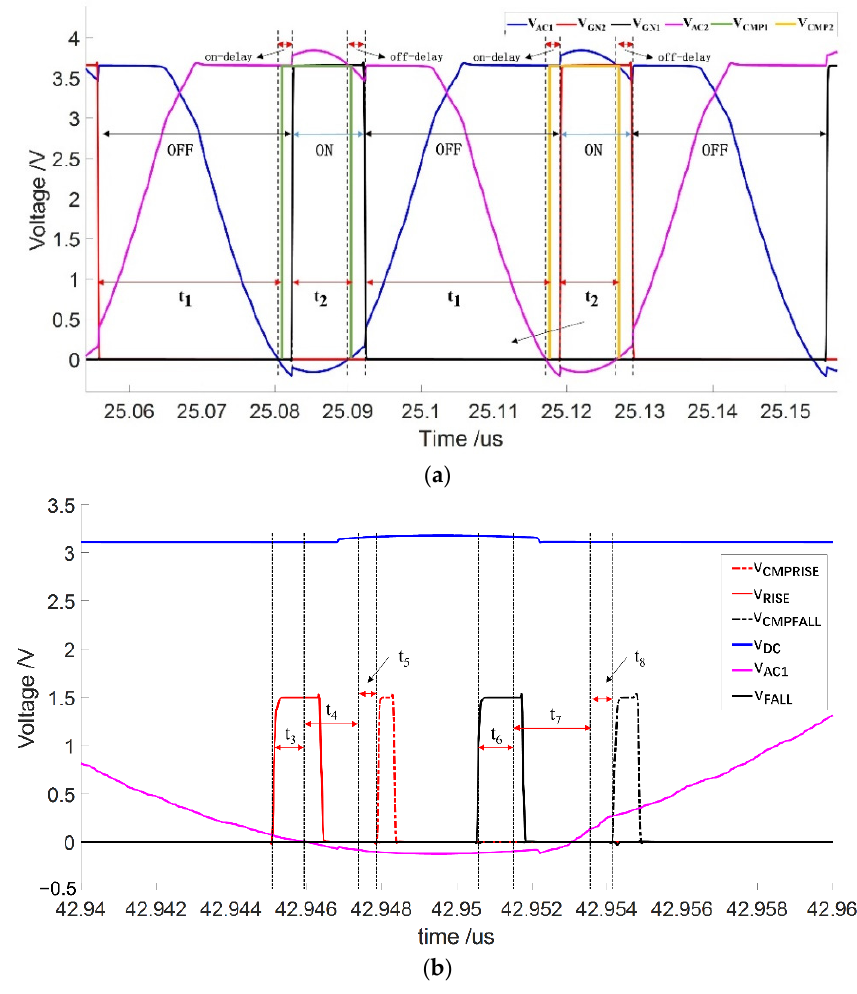
Figure 6. The waveforms of ( a ) rectifier working status and ( b ) various